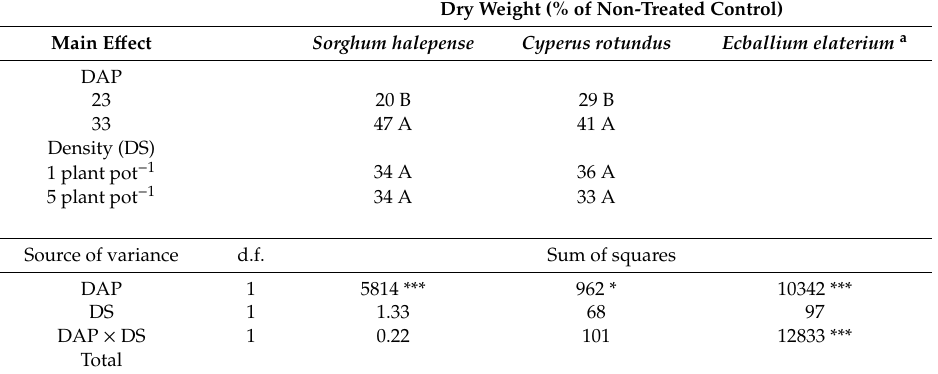
Table 3. Interaction between weed density (seeds pots − 1 ) or growth stage (days after planting (DAP)) and weed dry weight (% of non-treated control). Values with di ff erent letters are significantly di ff erent according to Tukey–HSD